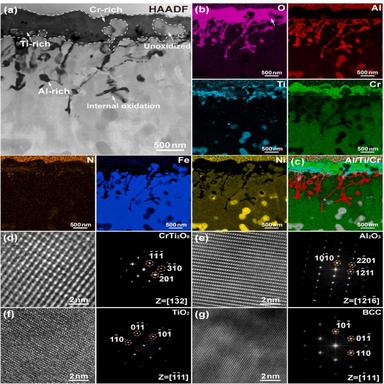
The TEM analysis of the cross-section oxide scale of Al8 CCA after 1 h oxidation at 800 ◦C in air. (a) HAADF image, (b) EDS mappings, (c) EDS mapping superposition of Al, Ti, and Cr elements, (d) HR-TEM and SAED of CrTi2O5 oxide, (e) HR-TEM and SAED of TiO2 oxide, (f) HR-TEM and SAED of Al2O3 oxide, (g) HR-TEM and SAED of BCC structure.